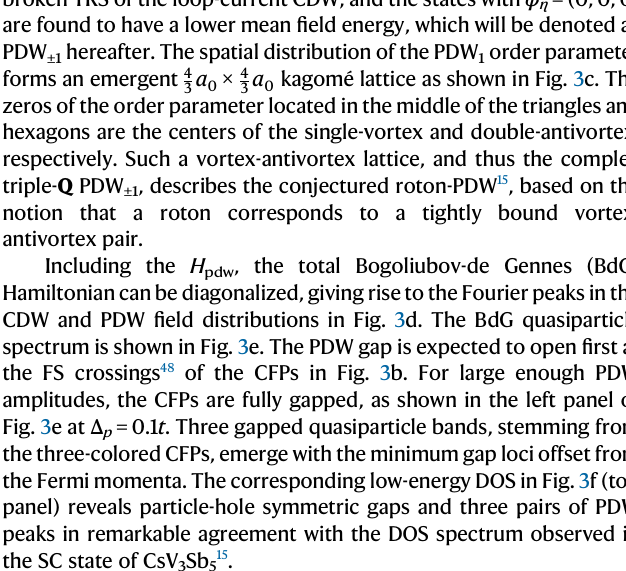
Fig.3|3 Q PDWandgappedCFPs.a StructurediagramoftheCFPs.Pocketsdrawn d Fourier peaks under coexisting 2 a 0 ×2 a 0 CDW and 4 in thick colored lines are connected by PDW wave vectors and carry most of the energy BdG quasiparticle bands in PDW 1 for Δ p =0.1 t (left panel) and 0.01 t (right panel)inthe4×4foldedBZin b .Greylinescorrespondto Δ p =0. f Low-energyDOS spectral weight (Fig. 2c). b Folded elliptical pockets in the 4×4 reduced BZ. c Spatialdistributionofthe 4 of PDW 1 . Top panel ( Δ p =0.1 t ) shows three pairs of coherence peaks at the PDW a 0 × 4 a 0 complexPDW 1 orderparameterfor Δ p =0.1 t , 3 3 with amplitude represented by color intensity and phase denoted by arrows. The gaps of the three low-energy bands. Lower panel ( Δ p =0.01 t ) shows a V-shaped SC gap. A k B T =10 − 4 t thermal broadening is applied. g Zoom-in of low-energy band emergentPDWkagomélatticeisshownbyredlines,whilethebackgroundkagomé dispersionsinsideredandblueboxesintherightpanelof e ,showingafullgapdue lattice by white lines. Vortex and antivortex at the center of the triangles and to PDW induced uniform hexagons are visible by the phase winding indicated by the arrowed black lines.